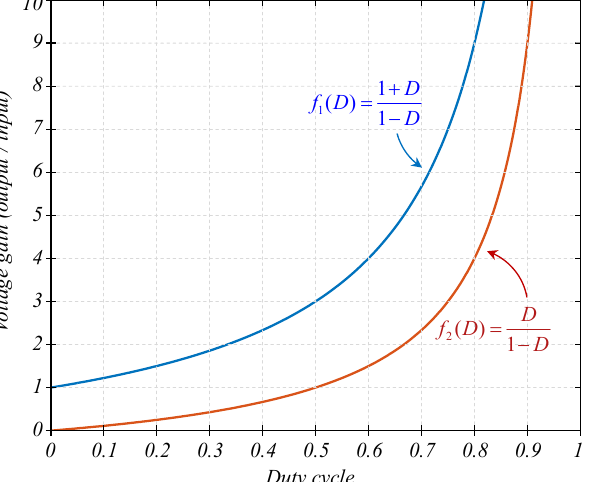
Figure 6. Voltage gains as a function of the duty cycle for the proposed and traditional boost con- verters.